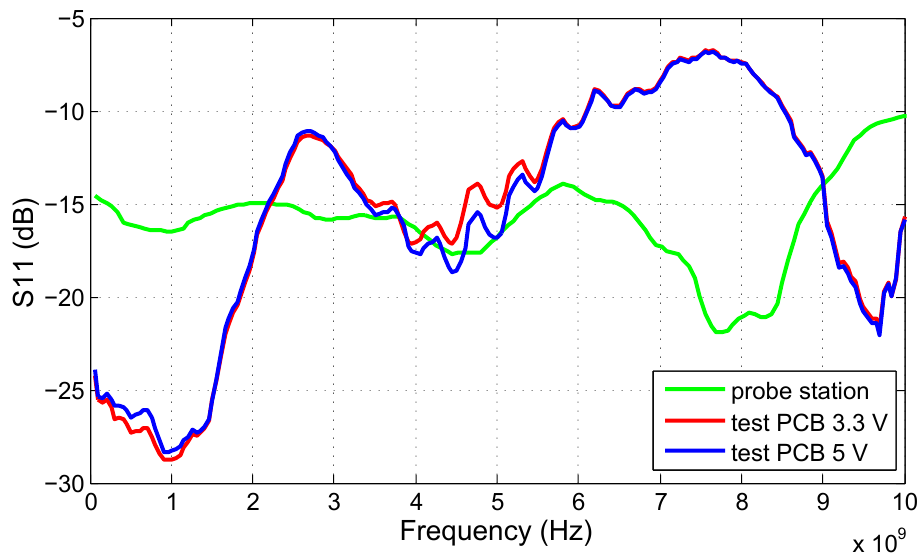
Figure 18. S11 of the proposed LCR driver measured at the probe station (green) on the test PCB with